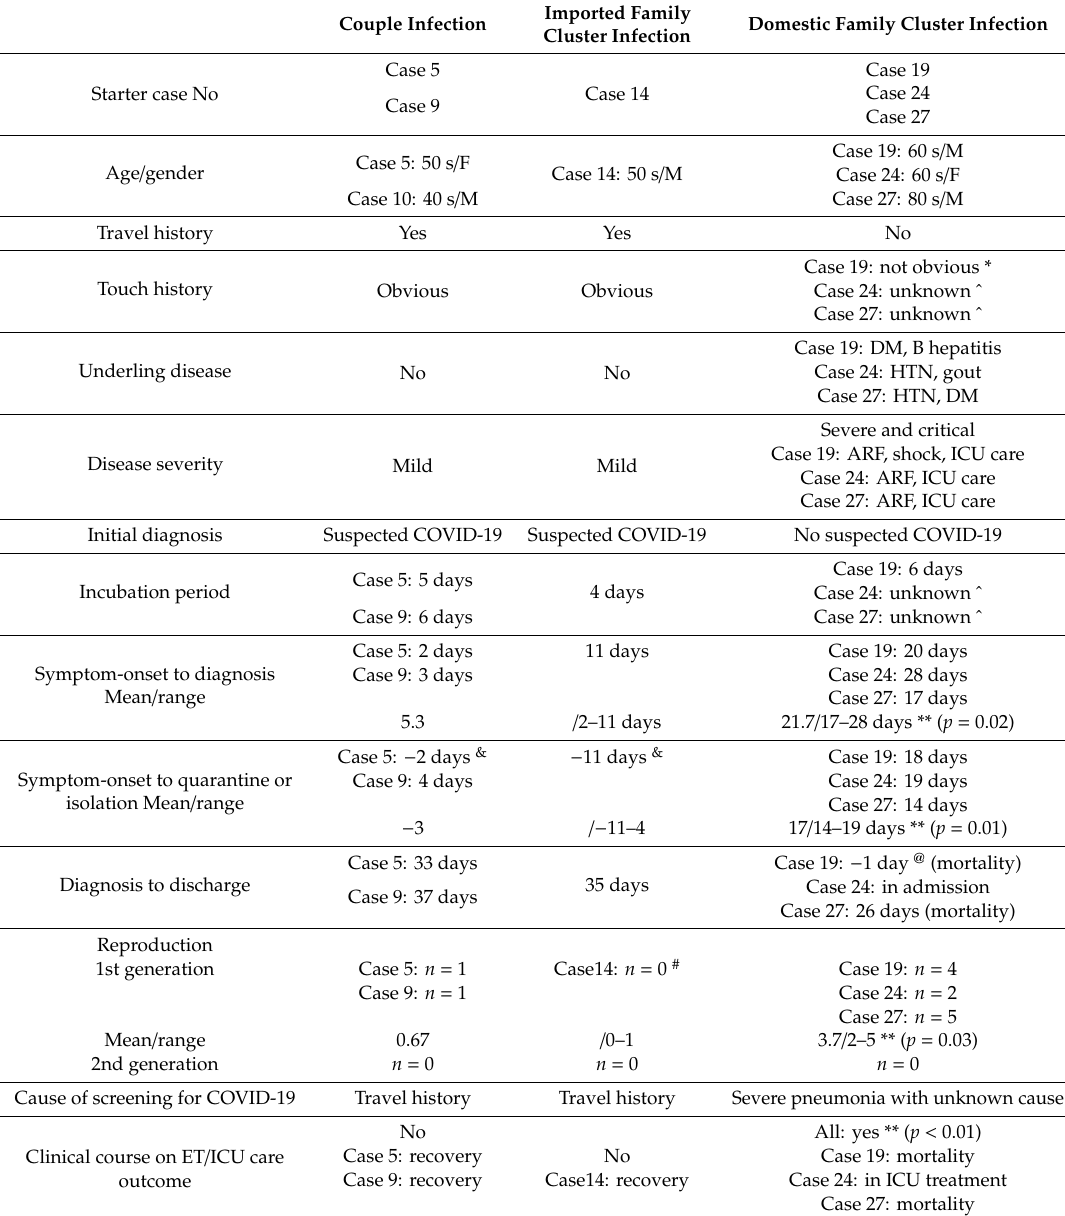
Table 1. Comparison of the characteristics and outcome of starters of di ff erent types of family infections with coronavirus disease 2019 (COVID-19) in